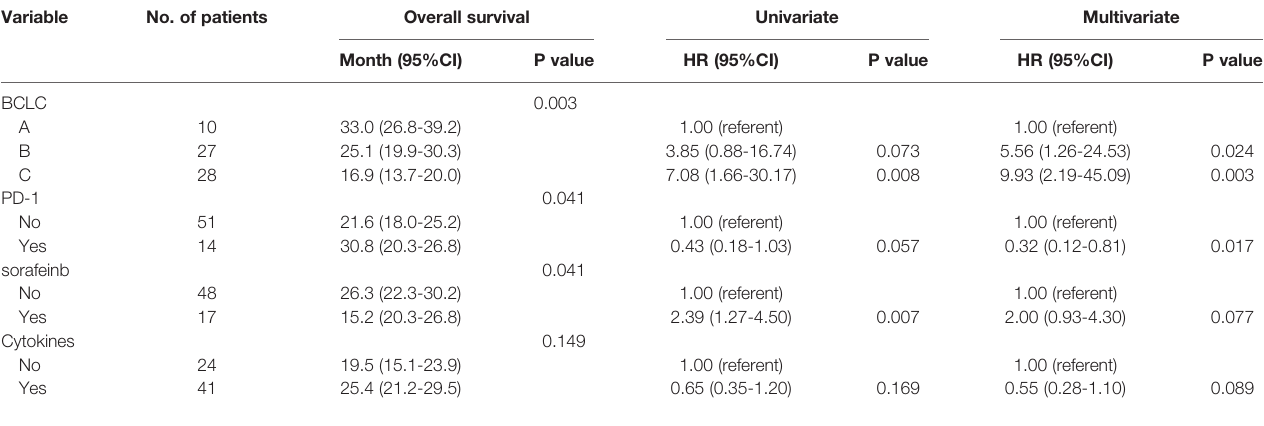
TABLE 3 | Cox regression analysis of overall survival of patients receiving radiotherapy.